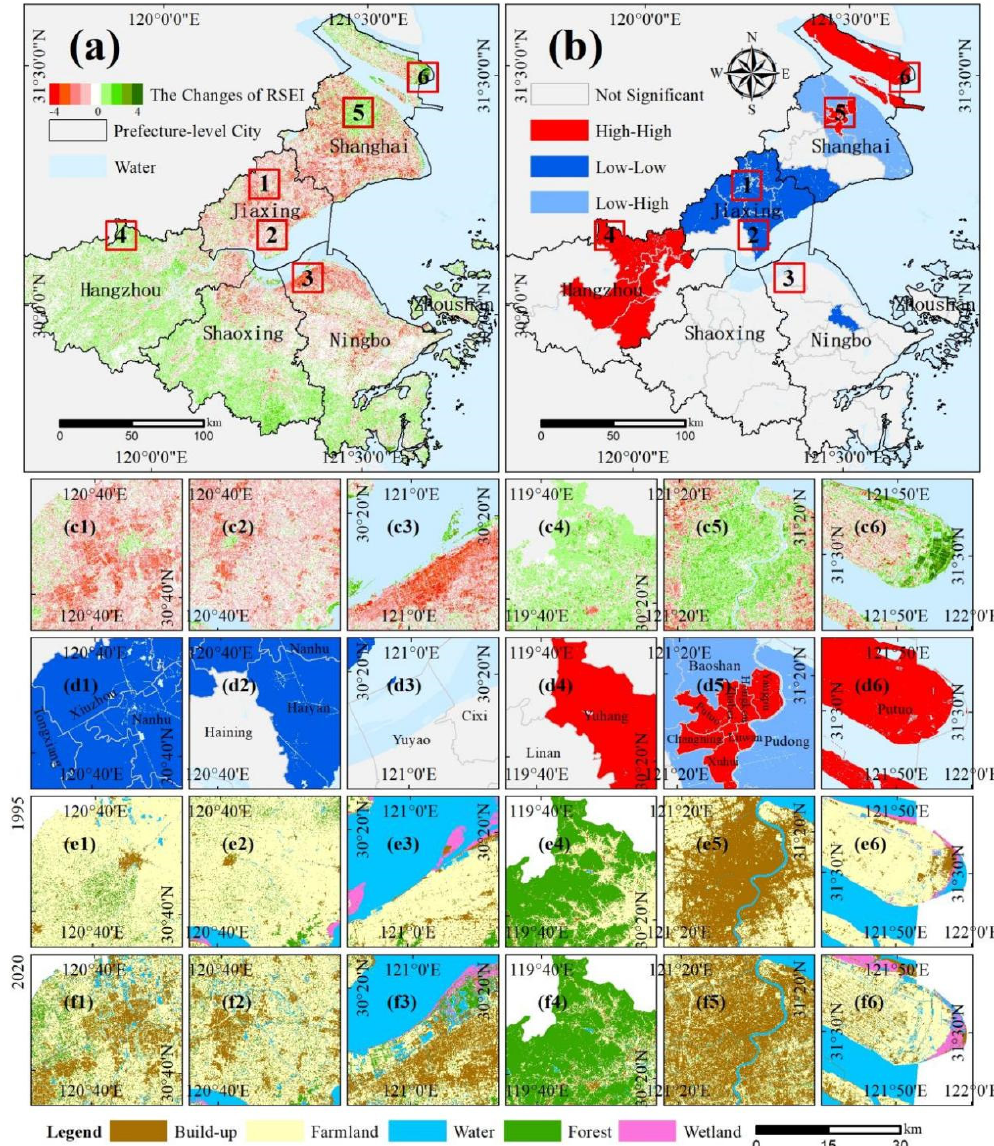
Figure 7. Hotspot areas for the changes in ecological quality from 1995 to 2020: ( a ) RSEI changes from 1995 to 2020, 1–3 and 4–6 are typical regions with increased and decreased RSEI; ( b ) different spatial correlations (High–High, Low–Low, and Low–High) reflected by local Moran’s I; ( c1 – c6 ), ( d1 – d6 ), ( e1 – e6 ), and ( f1 – f6 ) are enlarged sub-figures corresponding to the 6 typical regions in ( a ) to present RSEI changes, spatial correlations, land use types in 1995, and land use types in 2020.